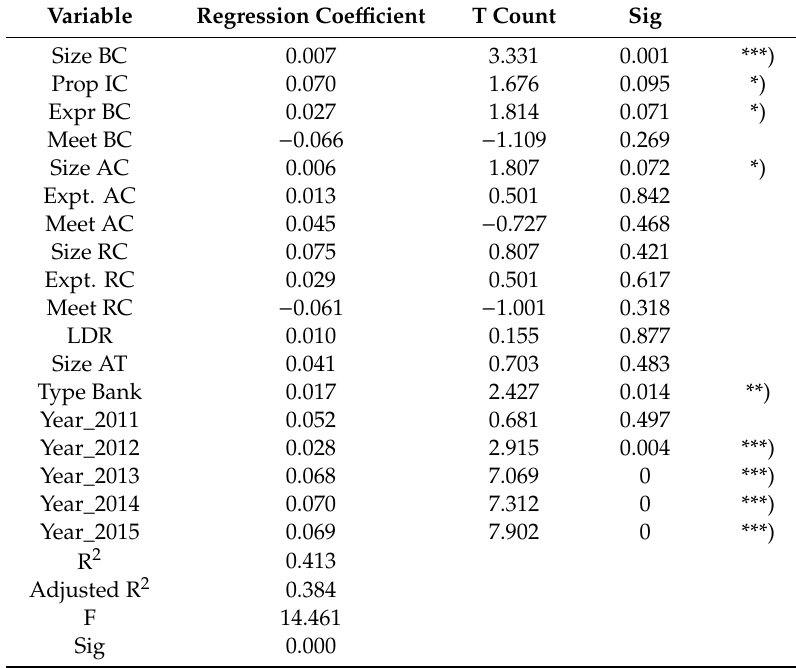
Table 4. Regression